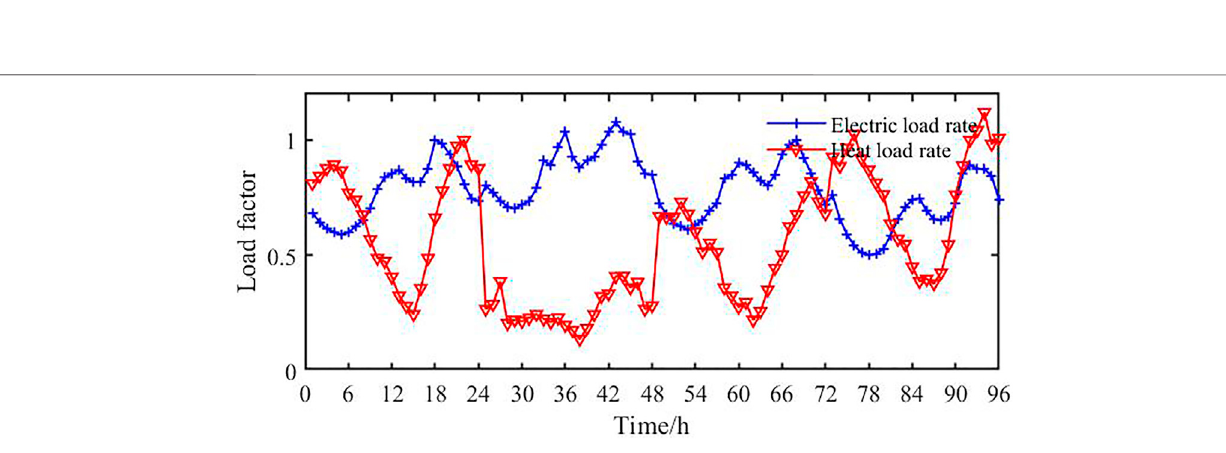
Appendix Table SB3 : R c = 1.1, K cw = 0.75 Yuan/kwh, K uw =